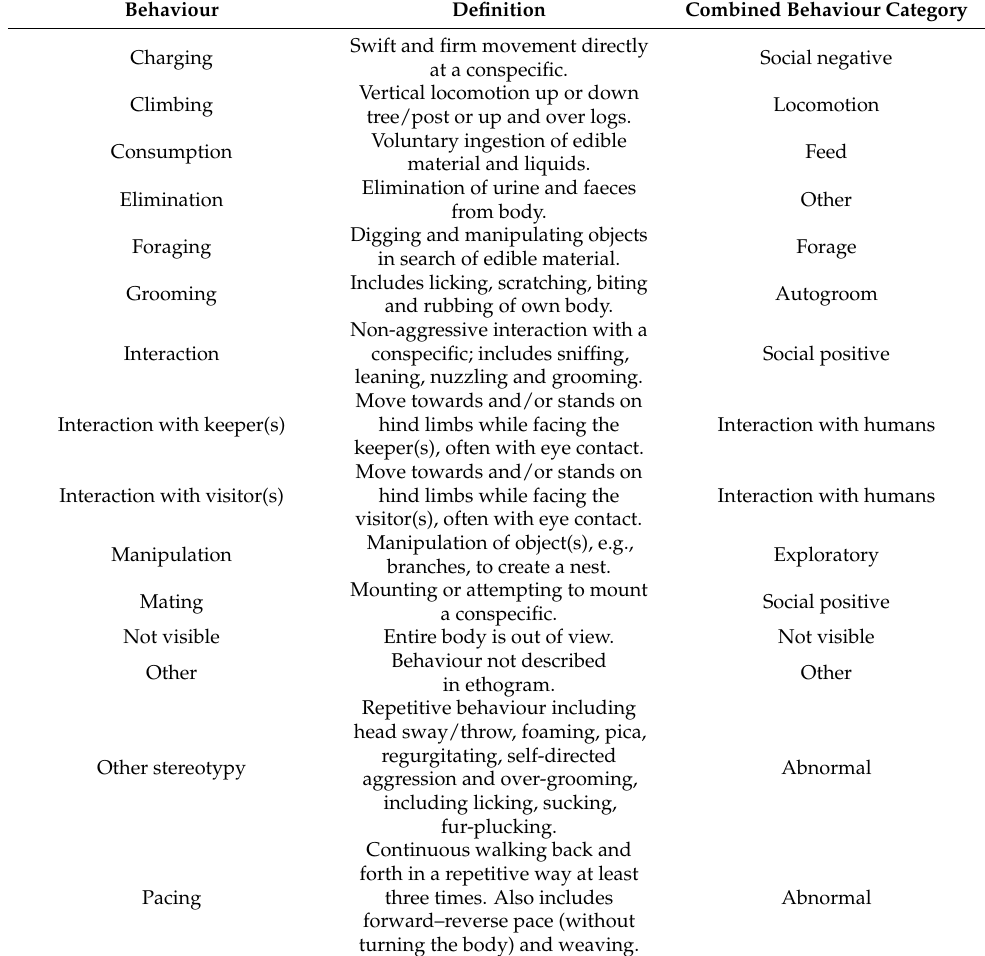
Table A3. Malayan sun bear ( Helarctos malayanus ) sub-project